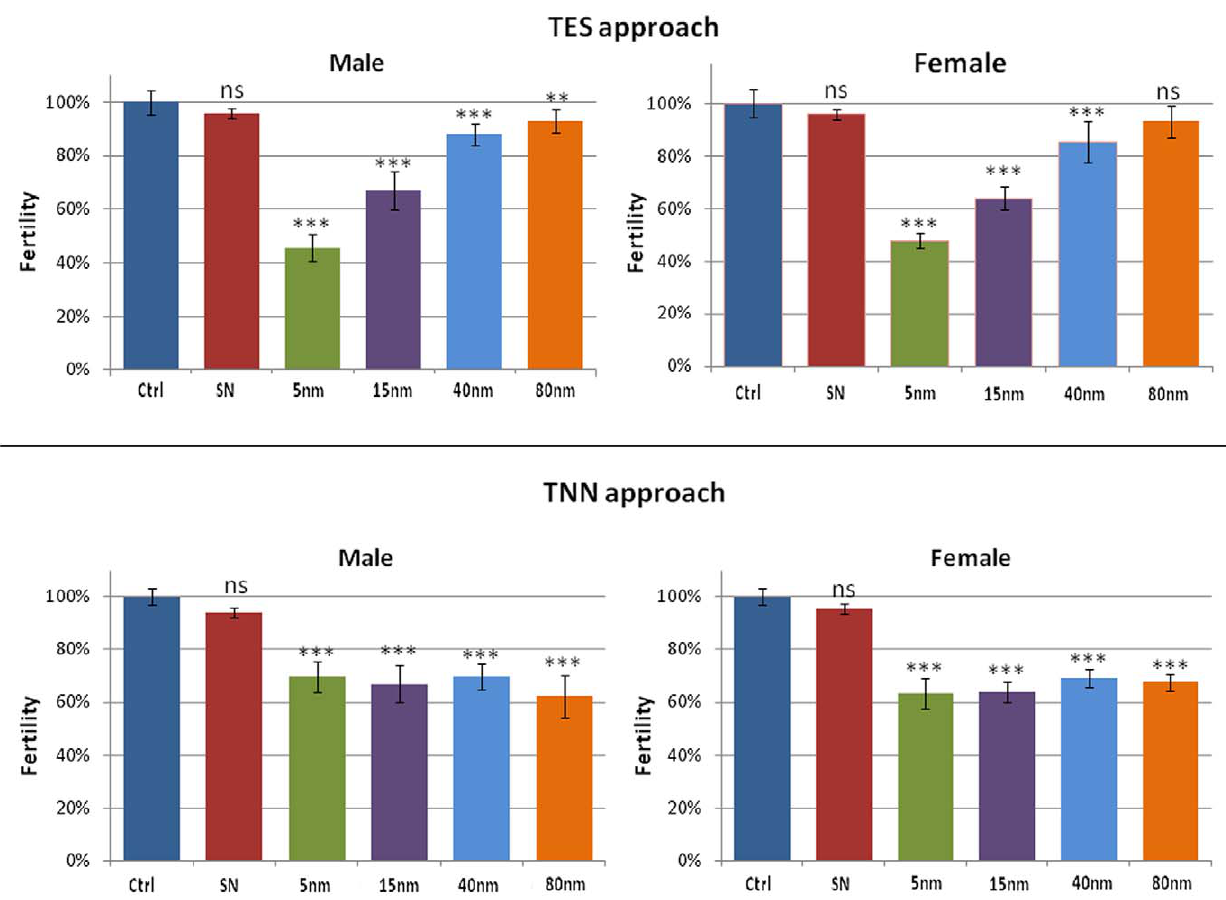
Figure 2. Male (left) and female (right) fertility tests relative to TES (top) and TNN experiments (bottom). Experimental points represent the average from 10 independent experiments and the error bars indicate the standard deviation (ns = non significant, i.e. p-value . 0.05; **p-value , 0.01; ***p-value , 0.001).